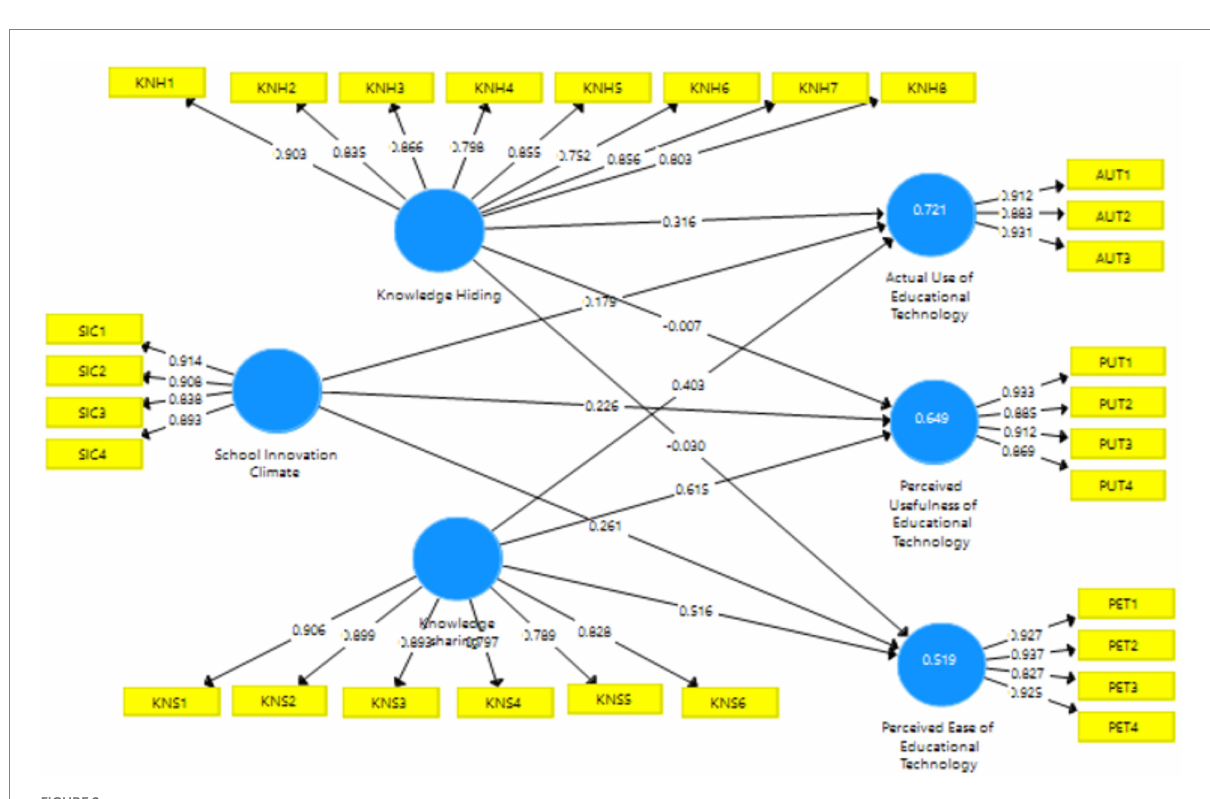
FIGURE 2 Measurement